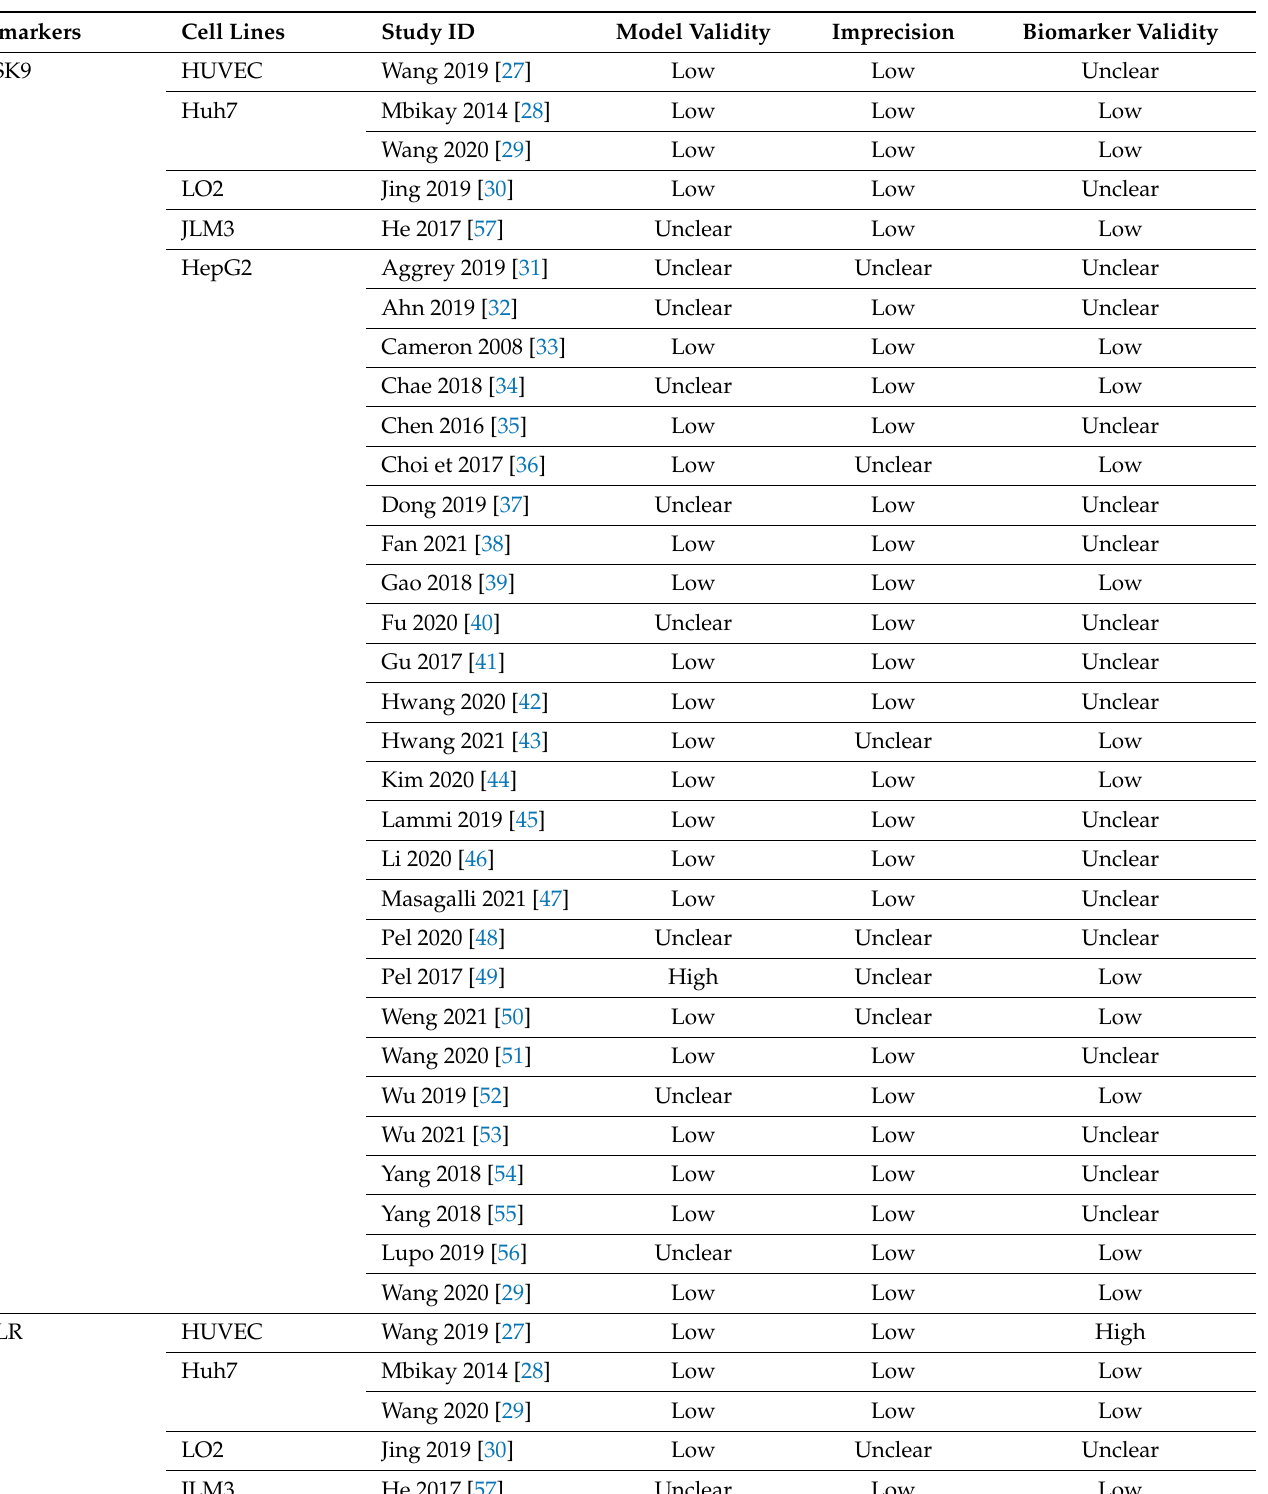
Table 2. Characteristic, model validity and imprecision of selected studies on the atherogene- sis